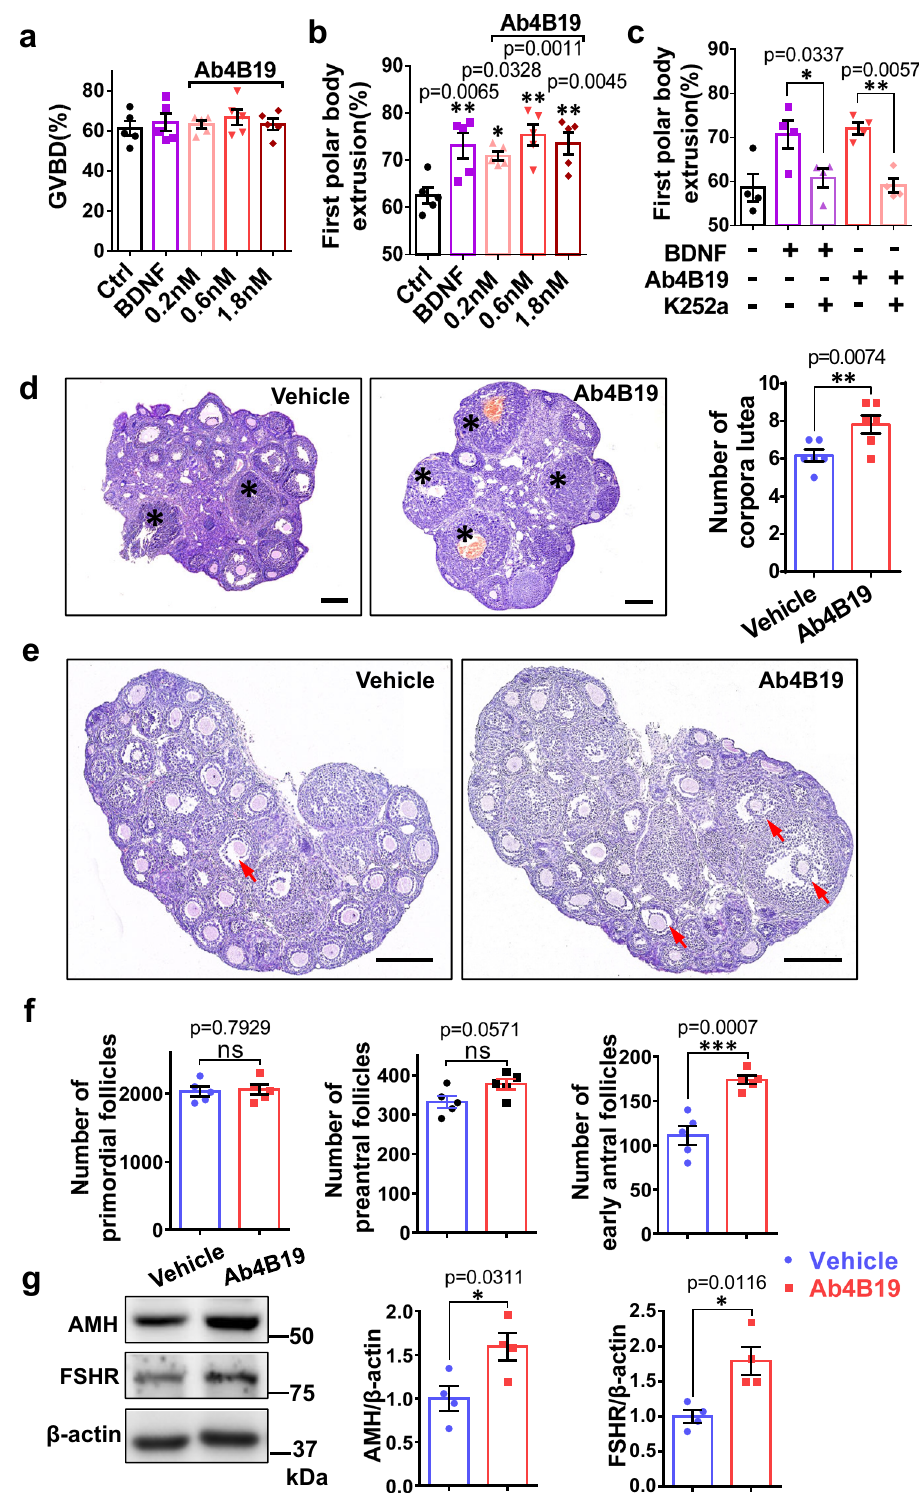
including body weight and appearance was done for these new- born mouse pups. The fertility index, namely the ratio of females delivered offspring/total females, was up to 38.7% for Ab4B19- treated group, and 14.2% for the vehicle-treated group. The average number of newborn pups per mouse reached 3.6 (ranged from 0 to 6) for the Ab4B19-treated group, but only 1.1 (ranged from 0 to 3) in the vehicle-treated group (Fig. 4e). The newborn